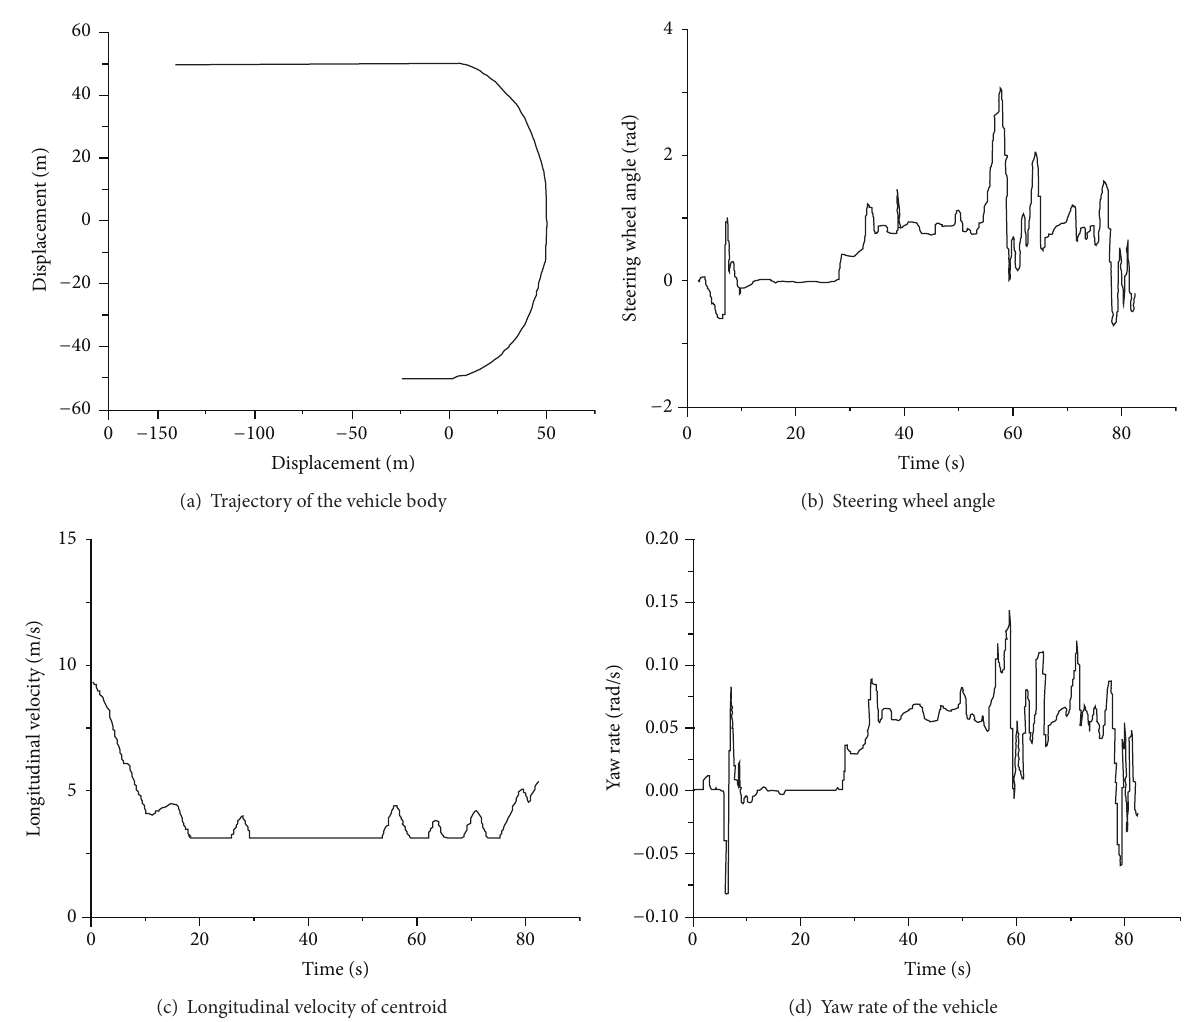
Figure 7: Vehicle concerning eliminating excessive